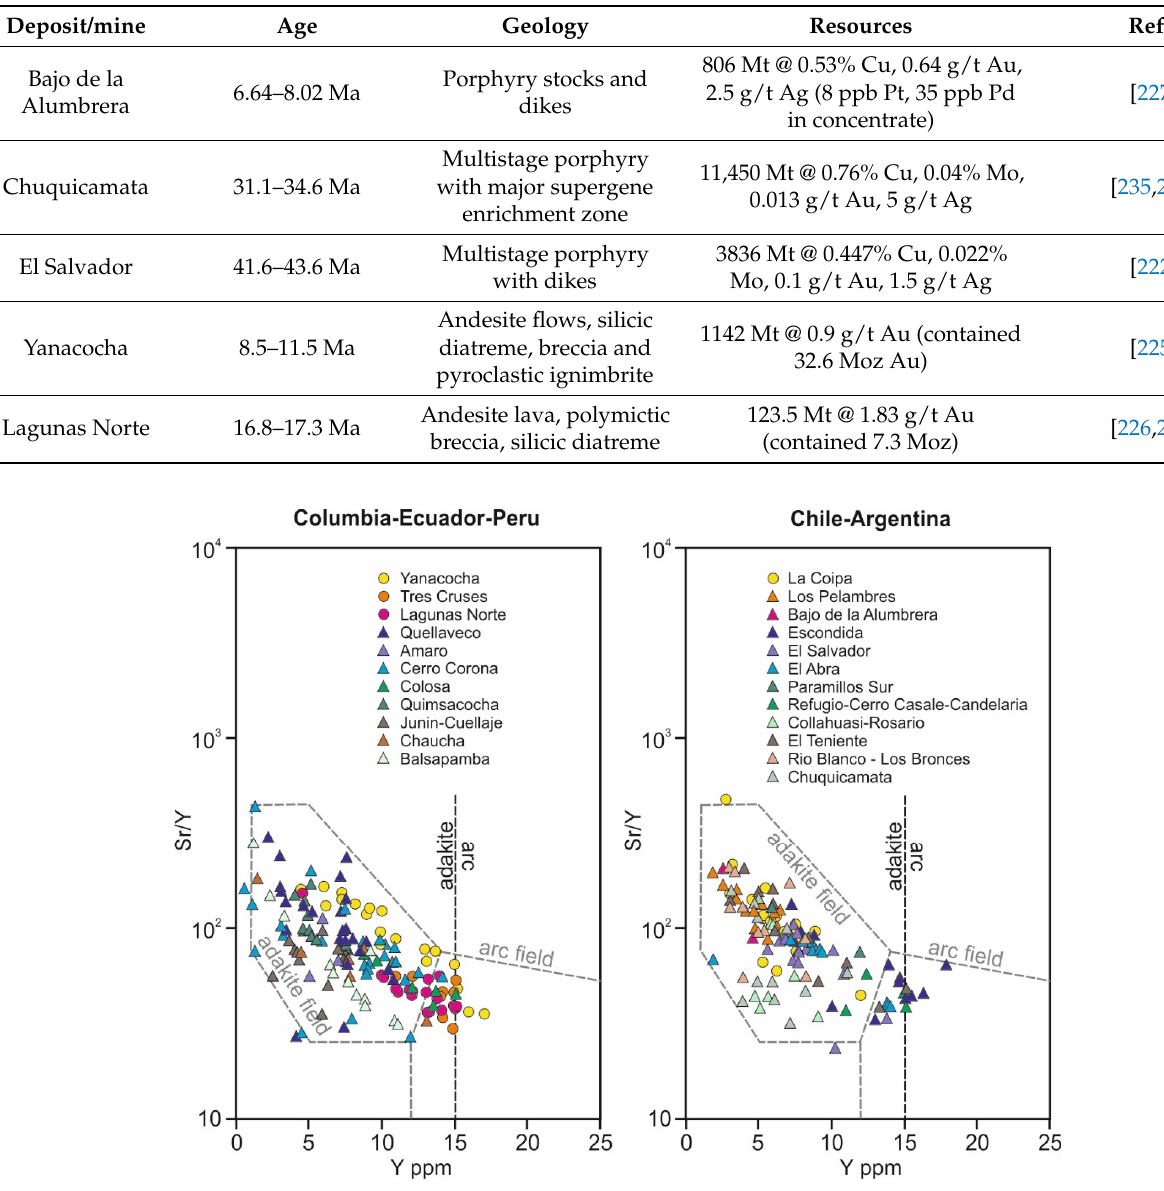
Figure 16. Variations of Sr/Y versus Y (ppm) in igneous rocks associated with porphyry Cu–Au–Mo (triangles) and epithermal Au–Ag (circles) deposits in the Andean magmatic arc. Data sources: